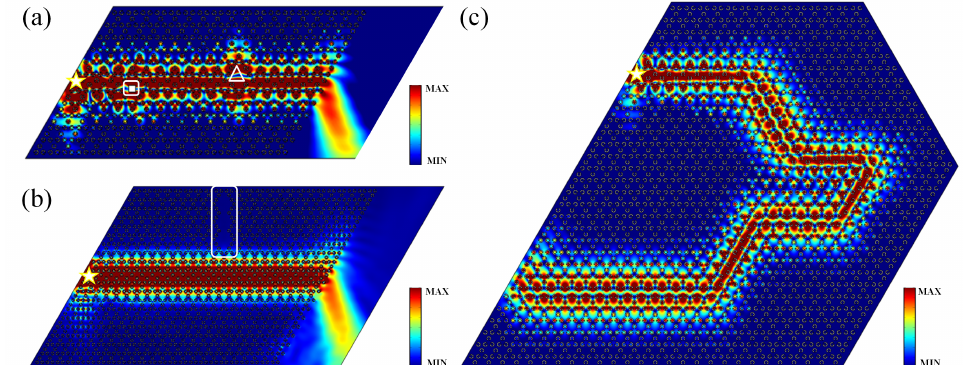
Figure A3. Simulated propagation of a light beam through the Zigzag interface with f = 0.102 THz. In ( a ), the tentagram, square, and triangle represent source, impurity, and defect, respectively. In ( b ), the tentagram and rectangle represent source and defect, respectively. In ( c ), the tentagram represents